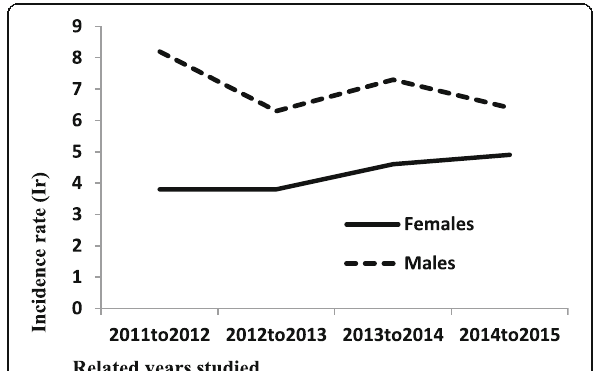
Fig 2 The estimated incidence of brain and other nervous system tumors related to each gender